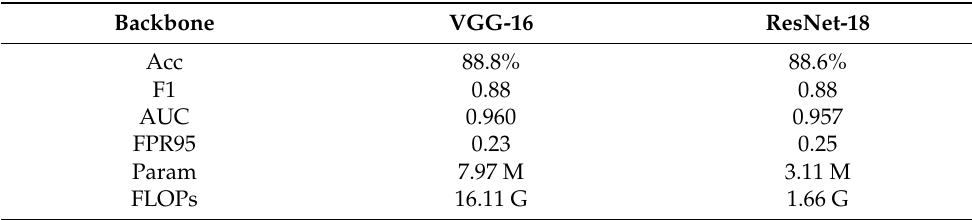
Figure 3. Architecture of ScoreCNN’s head. This part takes a correlation map as input and outputs the probability representing matching quality. Conv 3 × 3, 128 denotes a convolutional layer with a kernel of size 3 × 3 and the number of output channels 128. Table 1. Comparison of different backbones of ScoreCNN. Acc represents the accuracy. F1 represents the harmonic average of precision and recall. FPR95 represents the false positive rate at the true positive rate of 95%. Param and FLOPs represent the number of parameters and floating-point operations of the models, respectively.